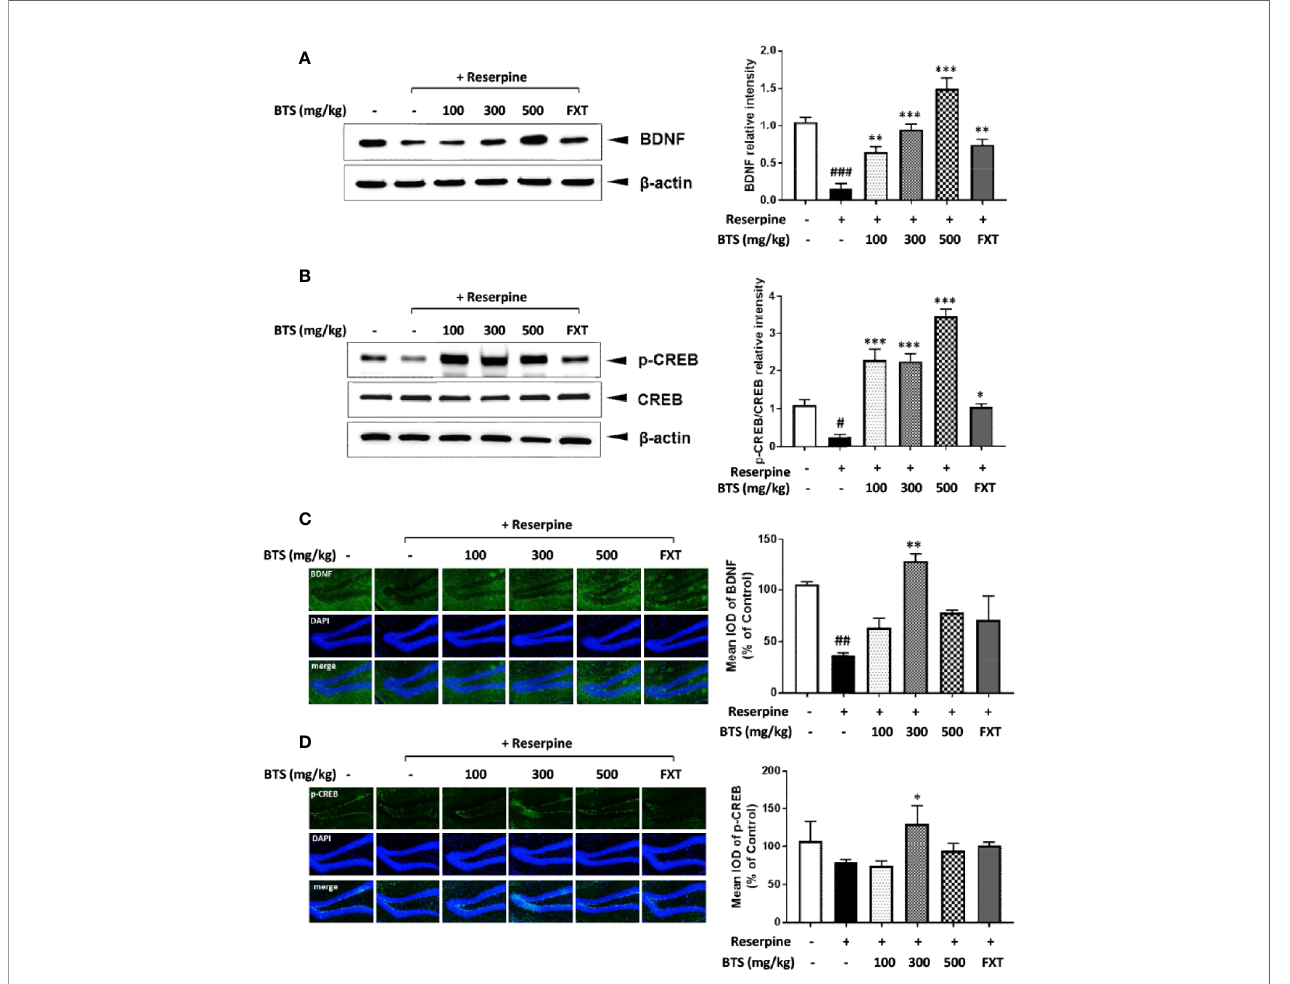
FIGURE 3 | Effects of BTS on BDNF and p-CREB/CREB expression and histology in the hippocampus of reserpine-induced depressed mice. Isolated hippocampus lysates were analyzed by western blotting using (A) BDNF and (B) p-CREB/CREB antibodies. b -actin was used as the loading control. Frozen hippocampus sections were analyzed by immuno fl uorescence using (C) BDNF and (D) p-CREB antibodies. DAPI was used as the loading control. The presented data are representative of three independent experiments. The data represent the mean ± SD (one-way ANOVA: # p < 0.05, ## p < 0.01, ### p < 0.001 vs. control; *p < 0.05, **p < 0.01, ***p < 0.001 vs.